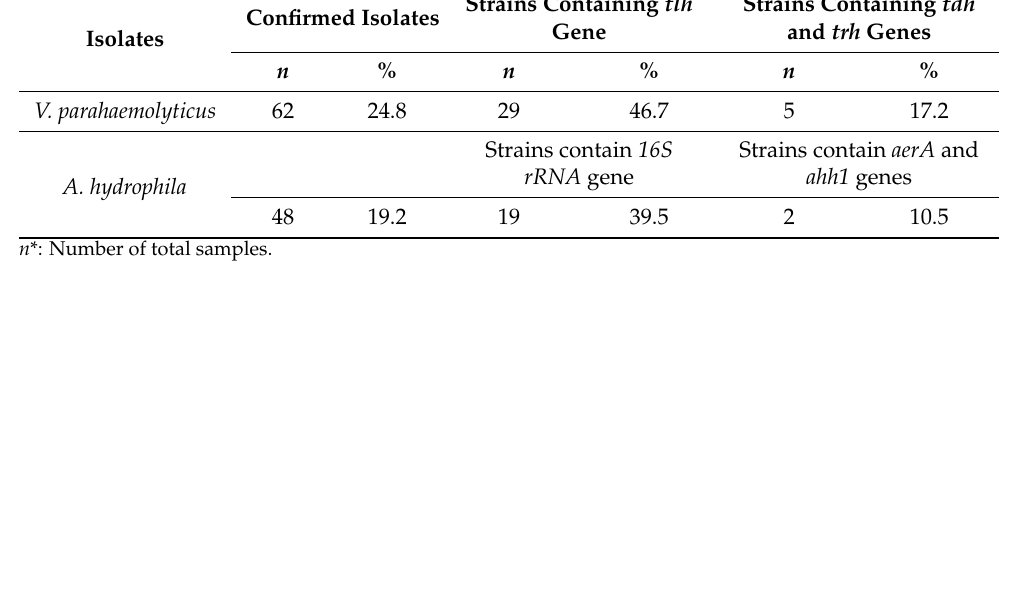
Table 1. Prevalence and molecular identification of confirmed isolates of V. parahaemolyticus and A. hydrophila in Nile tilapia ( n * = 250).